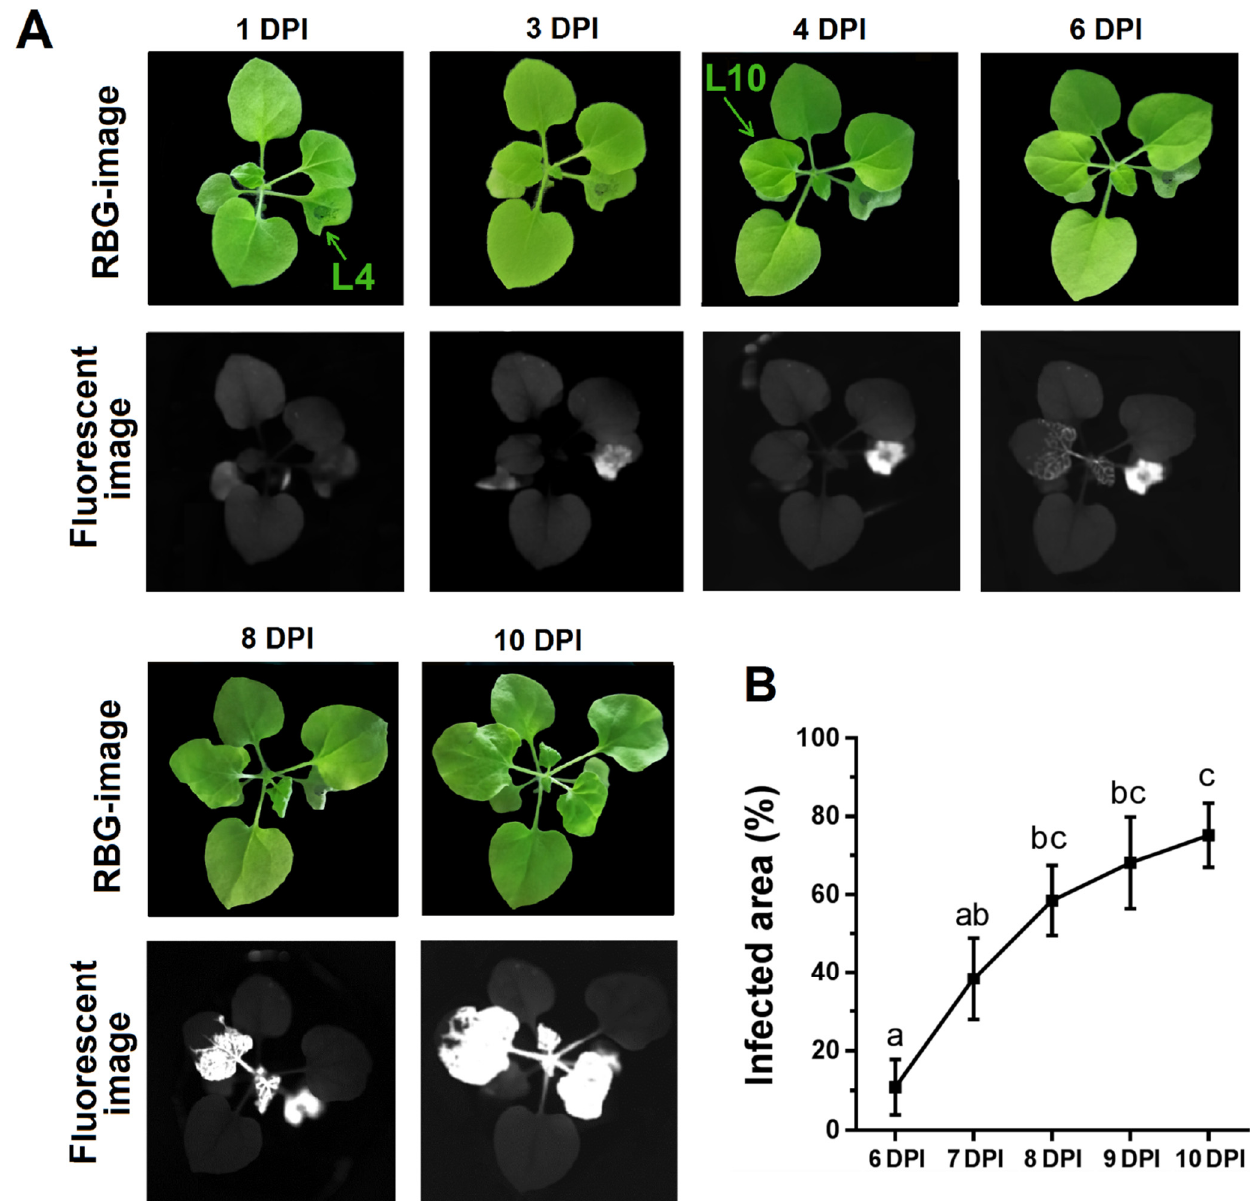
Figure 1. Distribution of PVX-GFP in the N. benthamiana plant at various days post-inoculation (DPI): ( A ) RGB and fluorescence ( λ ex 452/45, λ em 535/43 nm) images of whole plants obtained using surface fluorescence imaging. ( B ) Dynamics of the PVX-GFP infection area of the tenth tobacco leaf ( n = 5). Values are mean ± SEM. L4 is the fourth true leaf through which the plants were infected; L10 is the tenth leaf in which the systemic spread of the virus was recorded. Different letters indicate significant differences between treatments at p < 0.05 according to Duncan